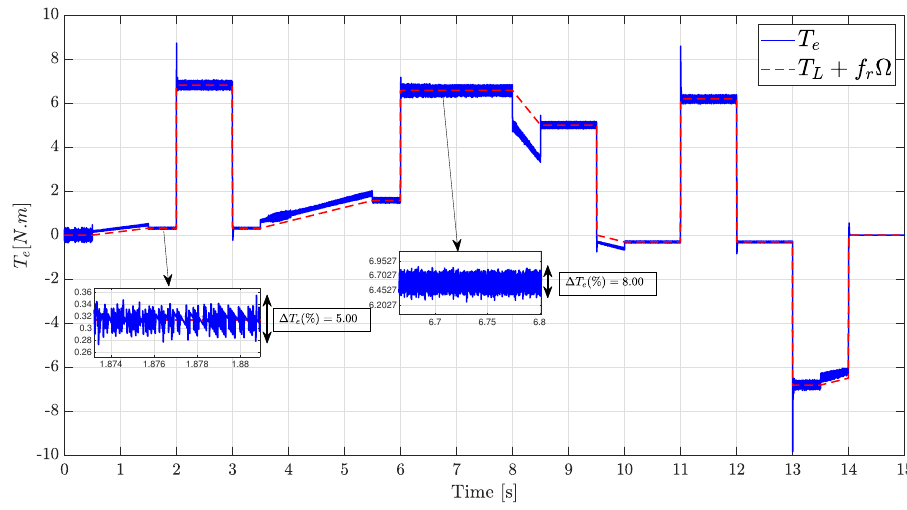
Figure 20. Torque response obtained by STA controllers and optimal currents calculations